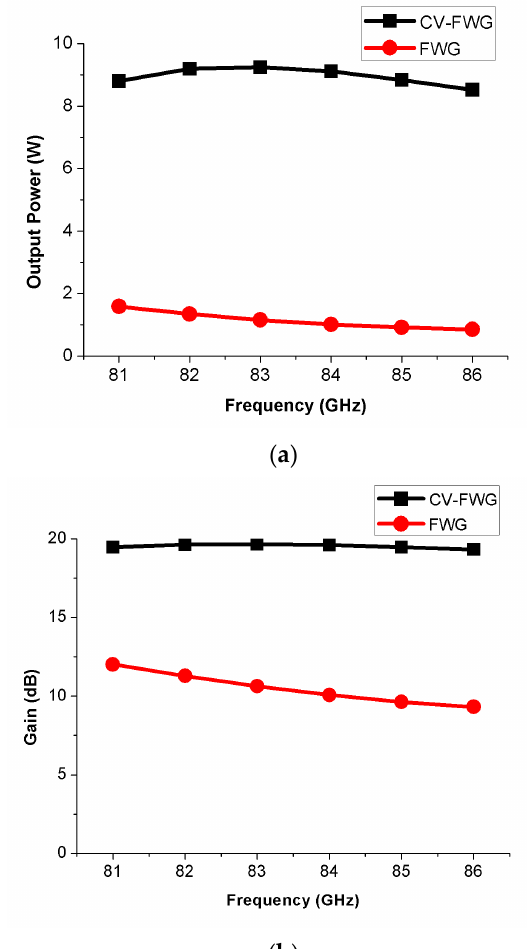
Figure 14. The output power ( a ) and gain ( b ) of CV-FWG and FWG simulated by MTSS. 3D PIC simulation software was used to predict the whole tube performance. A 3D model of a single section CV-FWG was built, which included the input and output couplers and a lossy metal housing (the conductivity was 1.6 × 10 7 S/m as shown in Figure 15. The PIC simulations were carried out on a cloud computing platform with about seven million mesh cells. Then the beam–wave interaction was calculated with a voltage of 9400 V, a current of 20 mA, and an interaction length of less than 50 mm. The radius of the electron beam is 0.06 mm, which is half of the radius of the electron beam channel. A sinusoidal RF-driven signal was applied. A uniform longitudinal magnetic field of 0.28 T was used in the PIC simulation. The simulation time is 6 ns for the bunching and amplifying. The total number of particles in the model is related to the model size and the simulation time. There are more than 1.73 million particles in this model. Figure 16 shows an amplified output signal at 83 GHz, with saturated power of more than 10 W less than 90 mW. The results of saturated power and gain are shown in Figure 17.